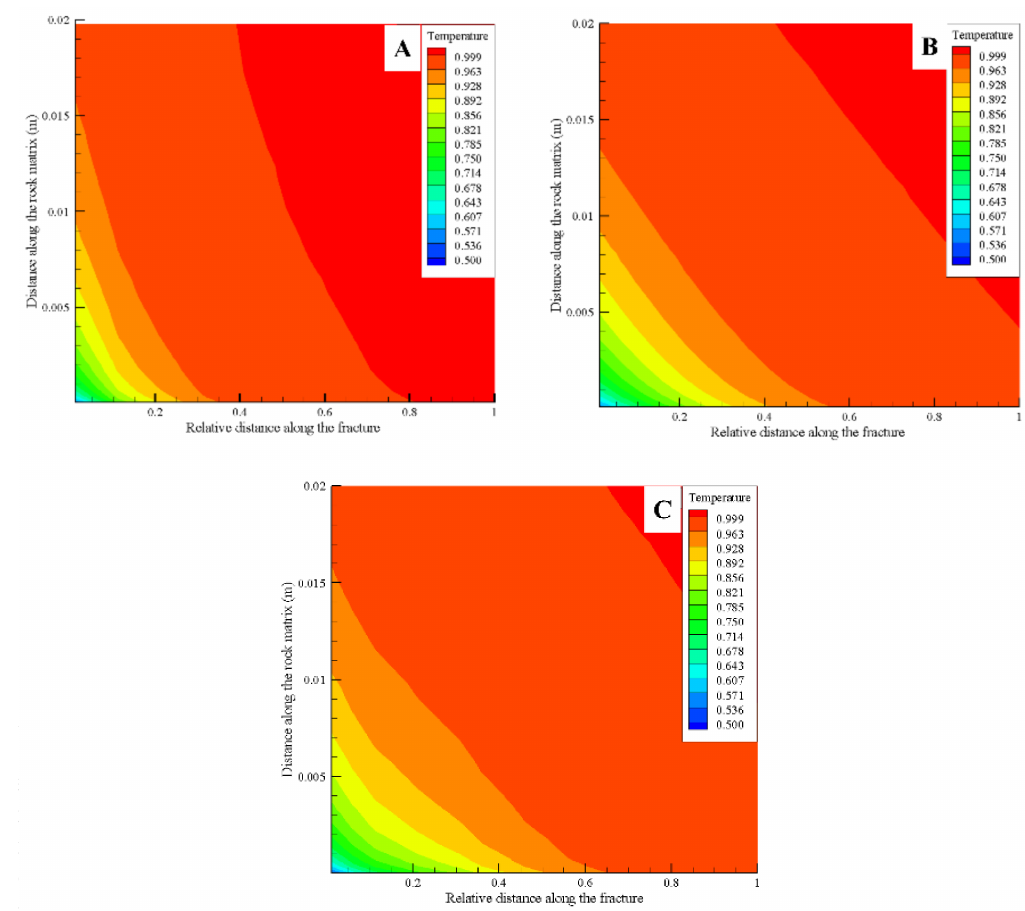
Figure 4. Contour representing the relative temperature variations in the rock matrix for parallel ( A ), sinusoidal ( B ), and LCG ( C ) fracture types at 100